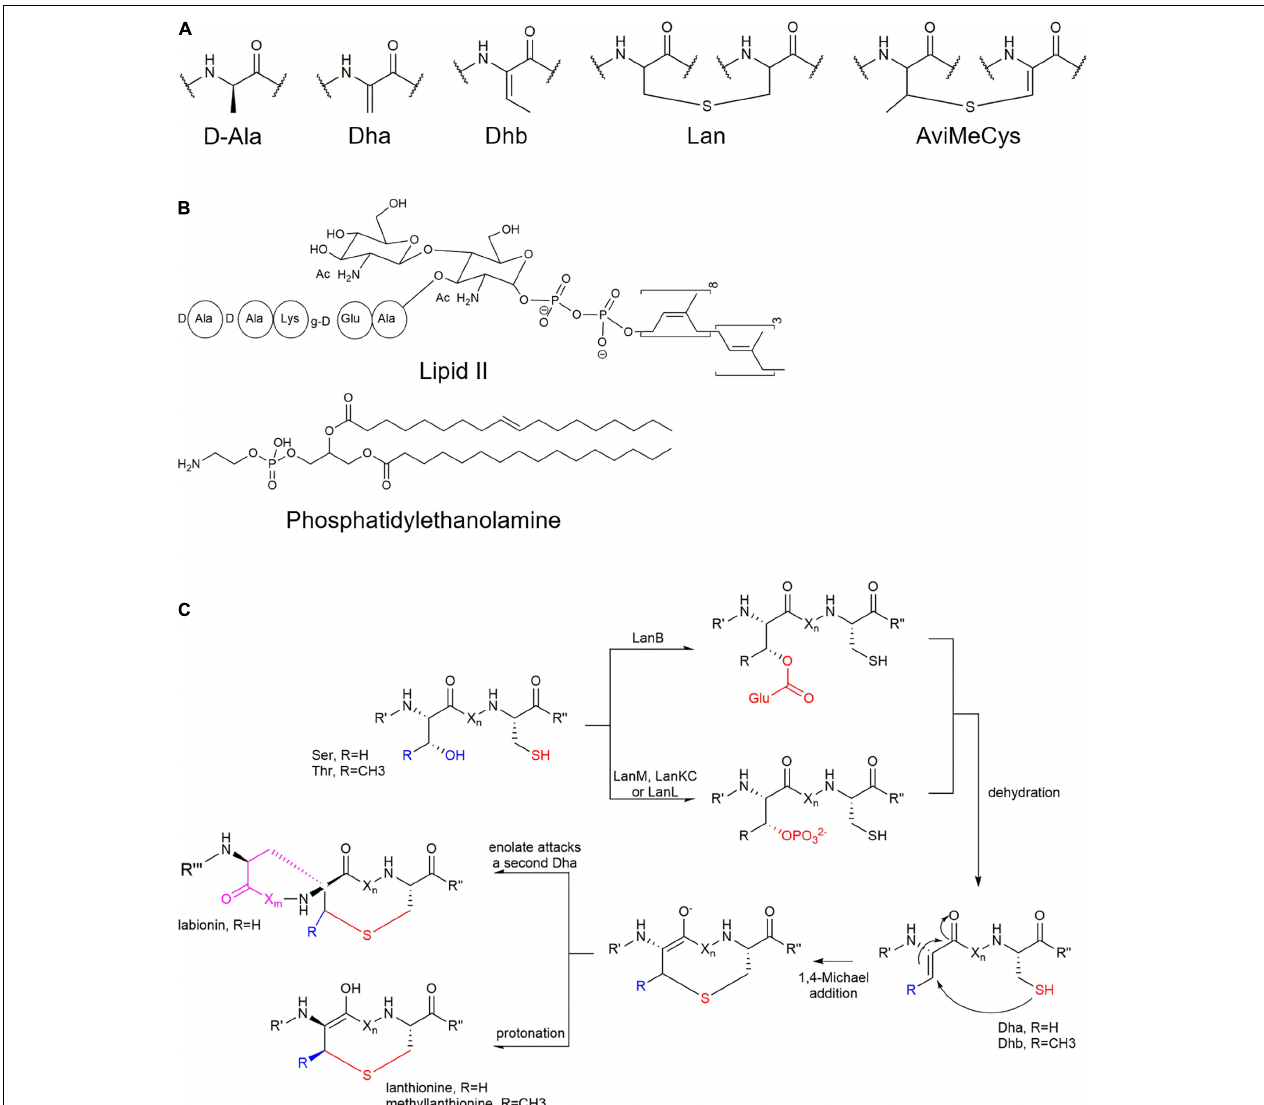
FIGURE 2 | Formation of unusual amino acid residues and action targets of lanthipeptides. (A) Unusual amino acid residues in the lanthipeptides. (B) Two main action targets of lanthipeptides. (C) Formation of characteristic lanthionine (Lan) or methyllanthionine (MetLan). Firstly, Ser/Thr-OH is dehydrated and followed by Cys-SH nucleophilic attack and cyclization. In class I lanthipeptide, Ser/Thr-OH is activated by glutamination at the presence of tRNA Glu , followed by deglutamination and dehydration while in class II-IV, Ser/Thr-OH is phosphorylated by LanM/LanKC/LanL and then undergoes dephosphorylation and dehydration. In addition, the labionin in the class III structure is formed by the nucleophilic attack of another Dha enol anion (Ren et al., 2020). It is speculated that class V is also dehydrated through phosphorylation and dephosphorylation